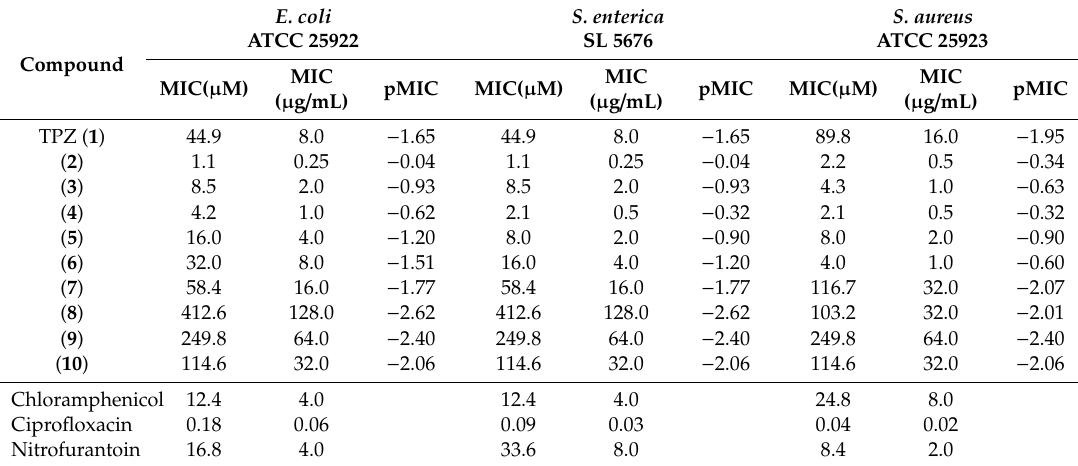
Table 1. The minimum inhibitory concentration (MIC) and inhibitory activity (in terms of pMIC = − log MIC ( µ M)) of TPZ ( 1 ), its derived compounds ( 2 – 10 ) and the reference antibiotics used against Gram-negative ( E. coli and S. enterica ) and Gram-positive ( S. aureus ) bacterial strains. E. coli S. enterica ATCC 25922 SL Compound